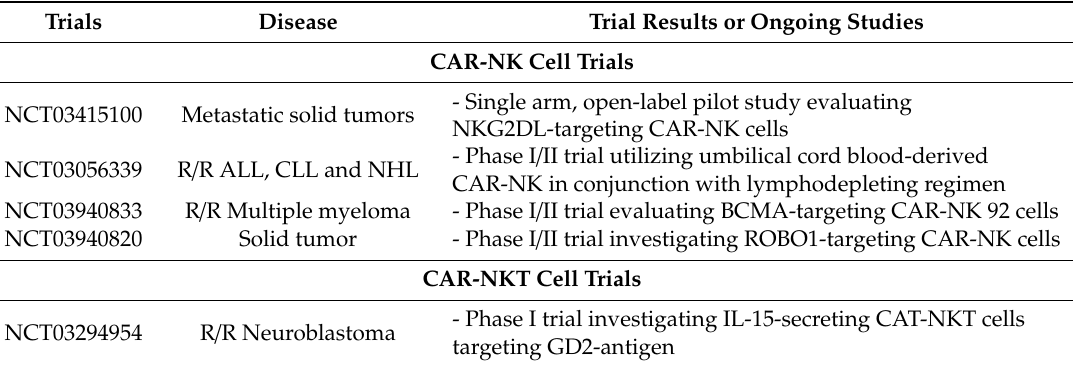
Table 2. Clinical trials involving CAR-NK or CAR-natural killer T (NKT)